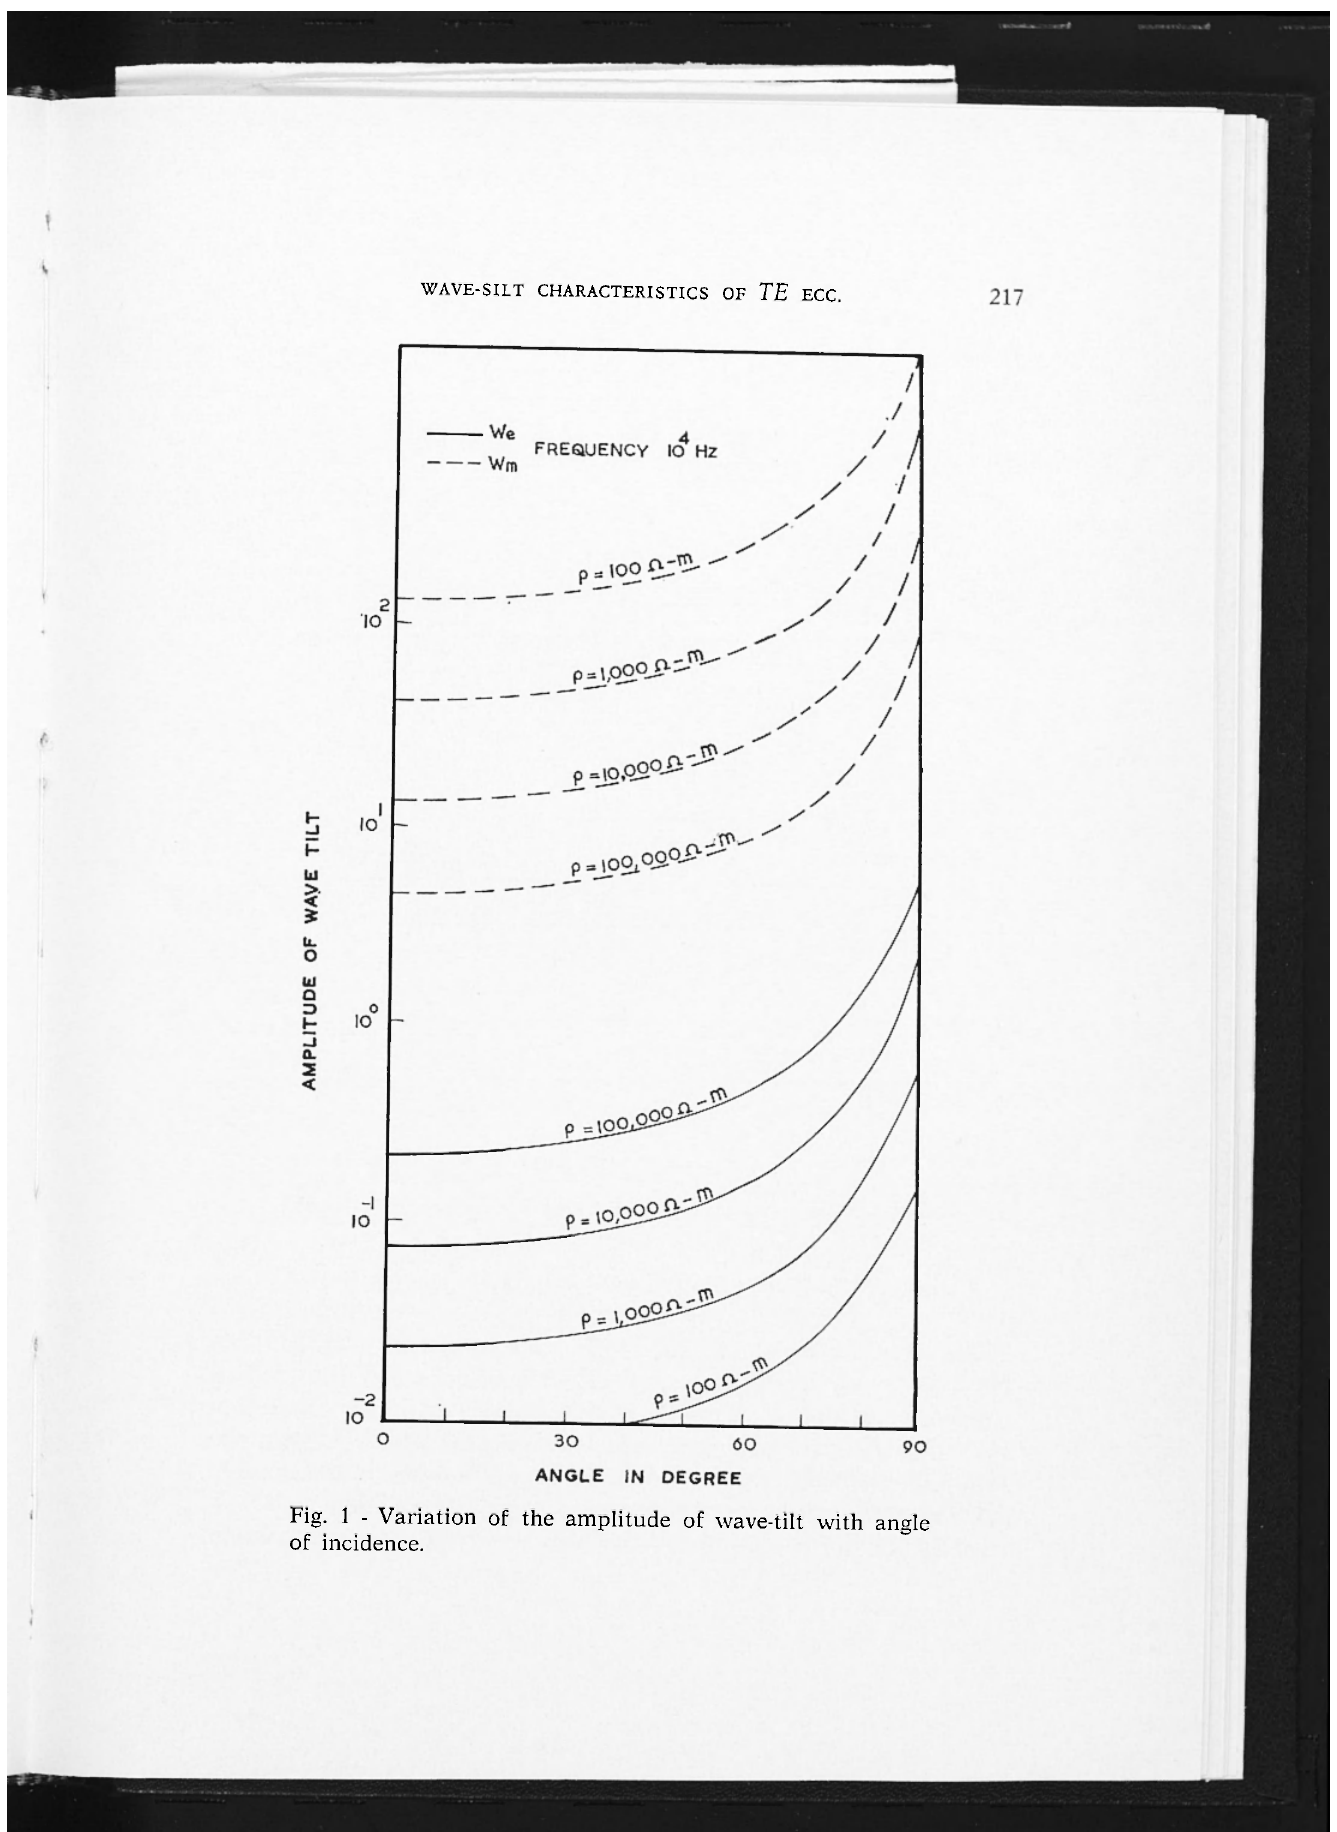
Fig. 1 - Variation of the amplitude of wave-tilt with angle of